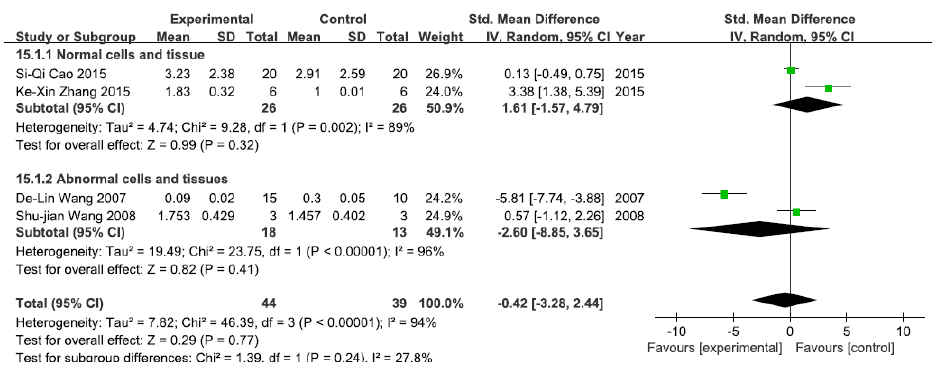
Figure 9. Effects of arsenic on nuclear transcription factor kappa B mRNA(NF ‐κ B mRNA). Forest plot showing the impact of arsenic treatment on NF ‐κ B mRNA compared with controls. Abbreviations: SMD = standardized mean difference, IV = independent variable, 95% CI = 95% confidence interval.